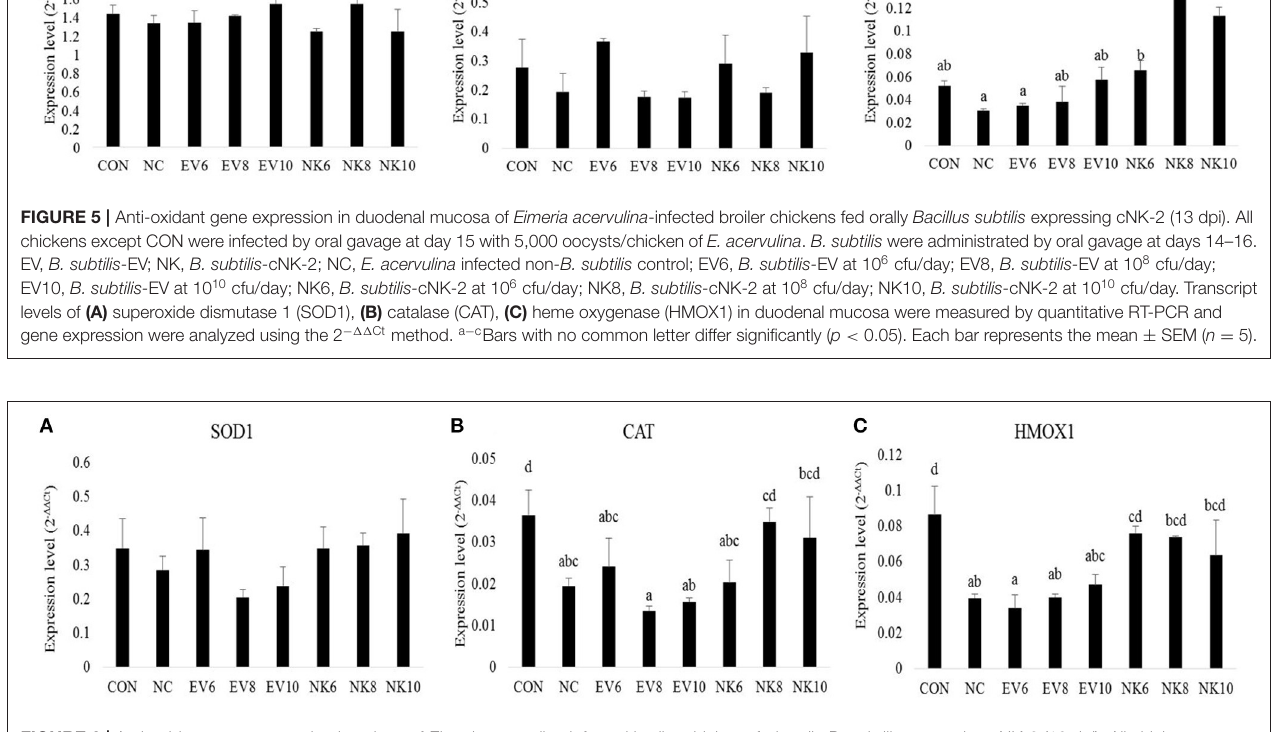
FIGURE 6 | Anti-oxidant gene expression in spleen of Eimeria acervulina -infected broiler chickens fed orally B. subtilis expressing cNK-2 (13 dpi). All chickens except CON were infected by oral gavage at day 15 with 5,000 oocysts/chicken of E. acervulina . B. subtilis were administrated by oral gavage at days 14–16. EV,v B. subtilis- EV; NK, B. subtilis- cNK-2; NC, E. acervulina infected non- B. subtilis control; EV6, B. subtilis- EV at 10 6 cfu/day; EV8, B. subtilis -EV at 10 8 cfu/day; EV10, B. subtilis- EV at 10 10 cfu/day; NK6, B. subtilis- cNK-2 at 10 6 cfu/day; NK8, B. subtilis- cNK-2 at 10 8 cfu/day; NK10, B. subtilis- cNK-2 at 10 10 cfu/day. Transcript levels